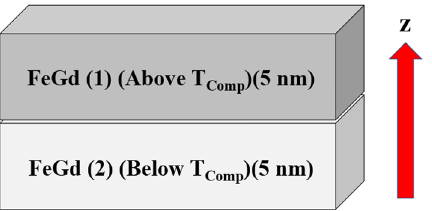
Figure 1. A schematic diagram of a synthetic antiferromagnet used in this study. Two 5 nm thick FeGd combines to form the synthetic antiferromagnet. In this study, layer 1 has T Comp at 350 K, above room temperature, and layer 2 has T Comp at 250 K, below room temperature. The z-direction in this study is defined as the out-of-plane direction.